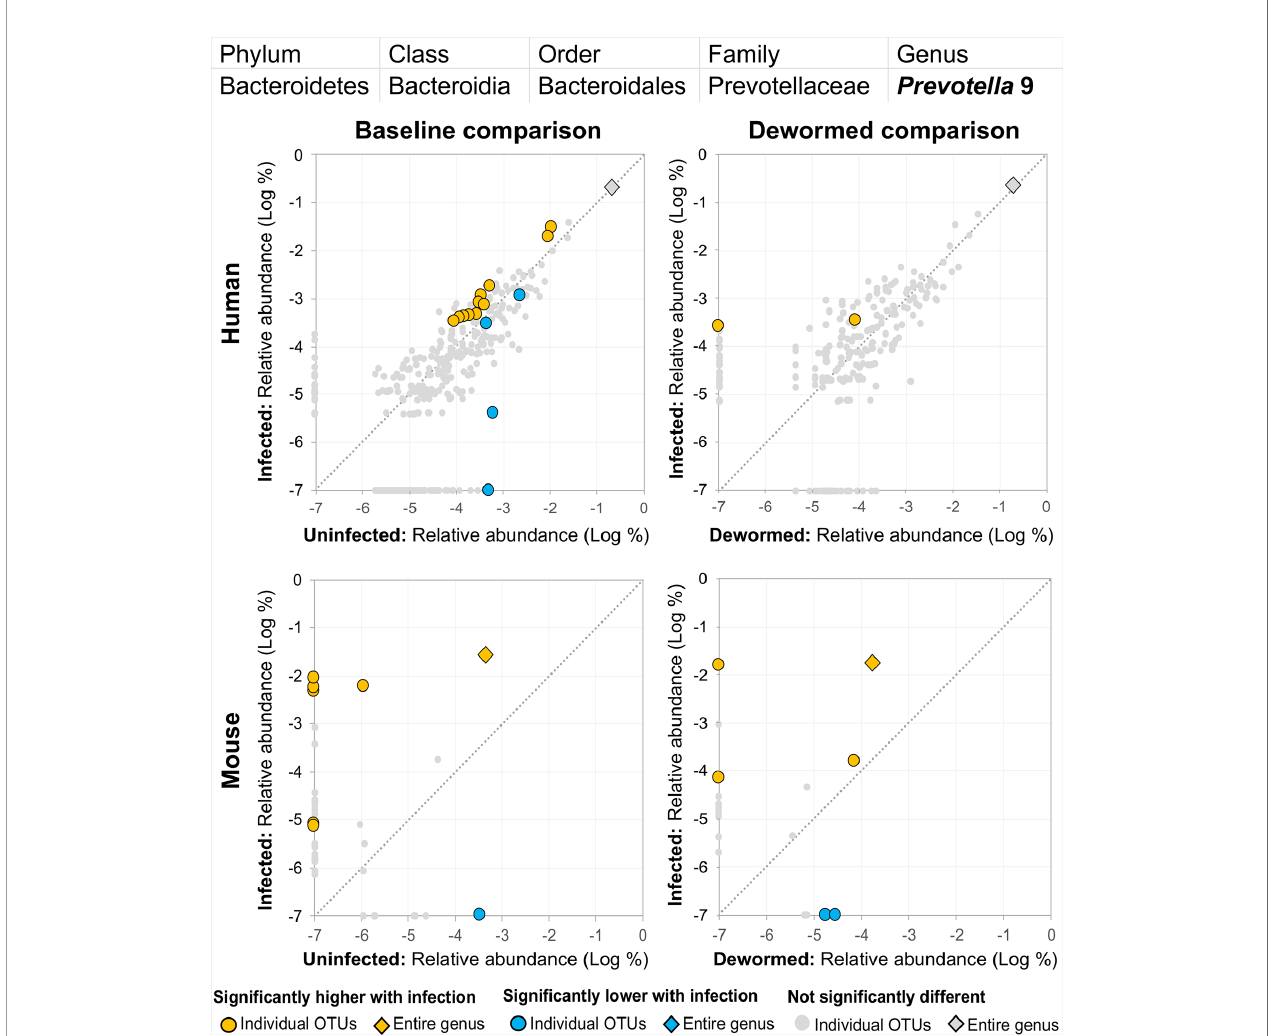
FIGURE 6 | The relative abundance (%) of all Prevotella 9 (genus) OTUs in each differential comparison among samples from whipworm-infected and uninfected humans and mice. Signi fi cant differentially abundant OTUs in each comparison (as identi fi ed by LEfSe) are colored in orange (higher with infection) and blue (lower with infection). The sum of all OTUs in the genus is represented with a diamond symbol. This is one of four genera with at least one OTU signi fi cantly higher in infection in all four comparisons and is also one of three genera with at least one OTU signi fi cantly lower in infection in three of four comparisons (because different OTUs were both higher and lower in the same